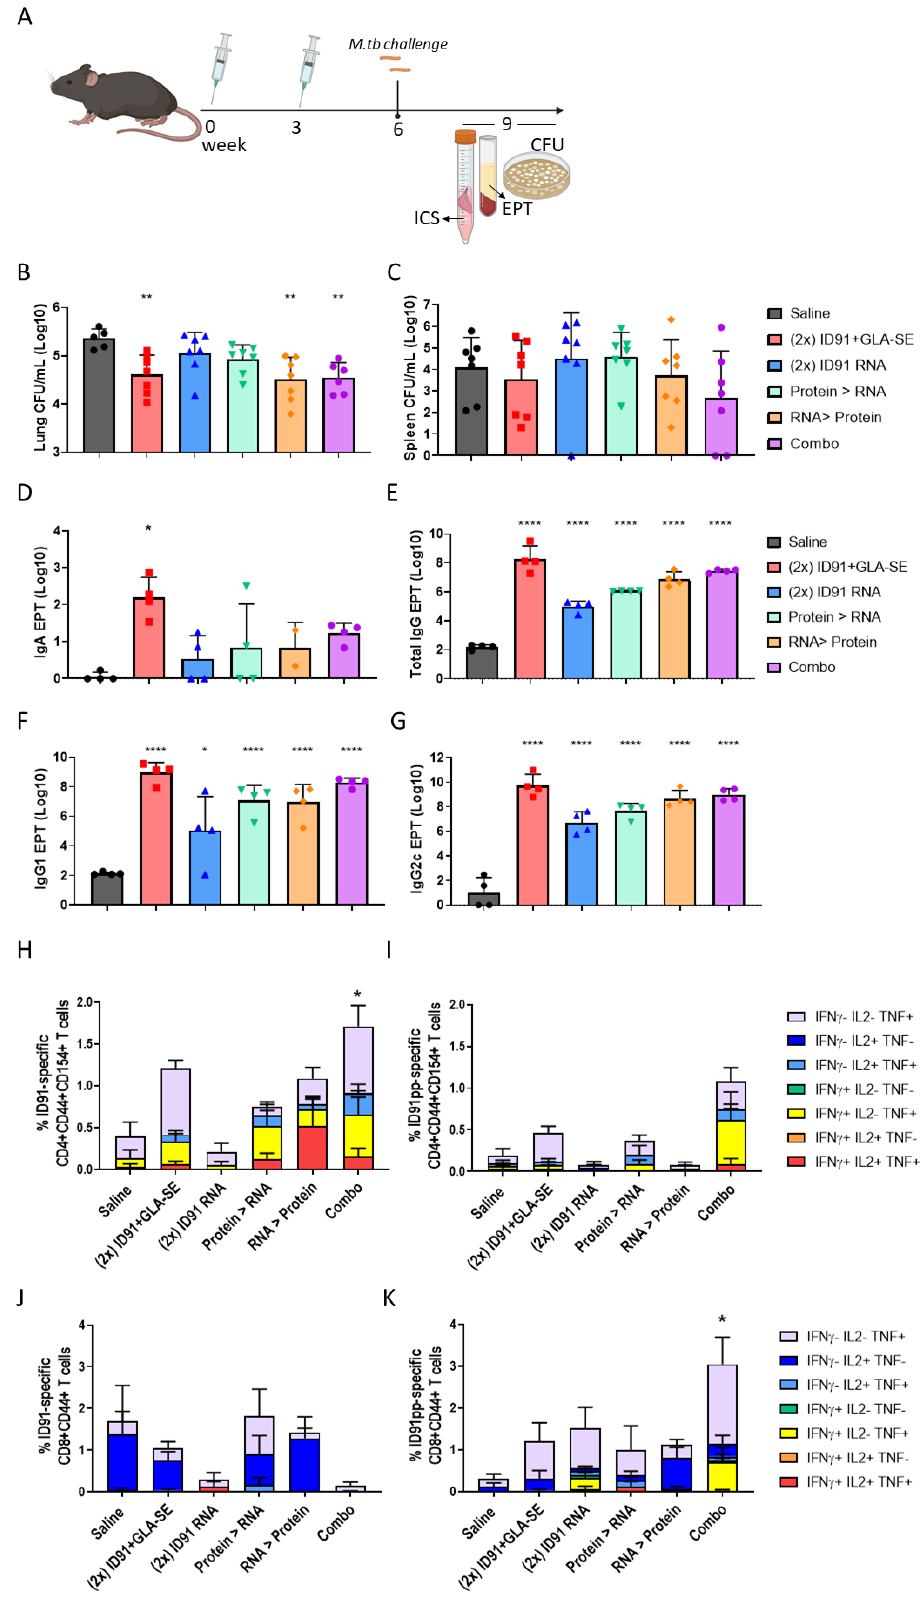
Figure 4. Regimen composition influences protection and post ‐ challenge immune responses. ( A ) vaccination and sample schematic. Bacterial burden assessed by colony ‐ forming units (CFU) in ( B ) the lung and ( C ) spleen homogenates 3 weeks post ‐ challenge. n = 6–7 mice per cohort, saline–grey, homologous ID91 + GLA ‐ SE–red, homologous ID91 repRNA +NLC–blue, protein prime/RNA